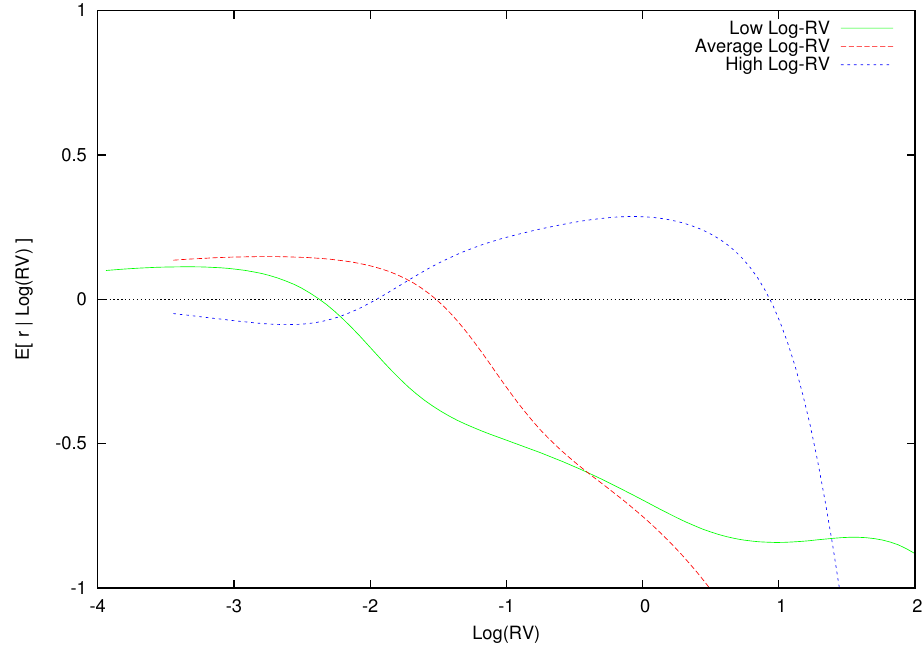
Figure 7. Expected excess return given log ( RV ) for various periods. This figure displays the expected excess return as a function of log ( RV ) conditional on regressors I t − 1 taken from t = 1964 : 10 “Low Log-RV”, t = 1996 : 2, “Average Log-RV” and t = 2008 : 12 “High